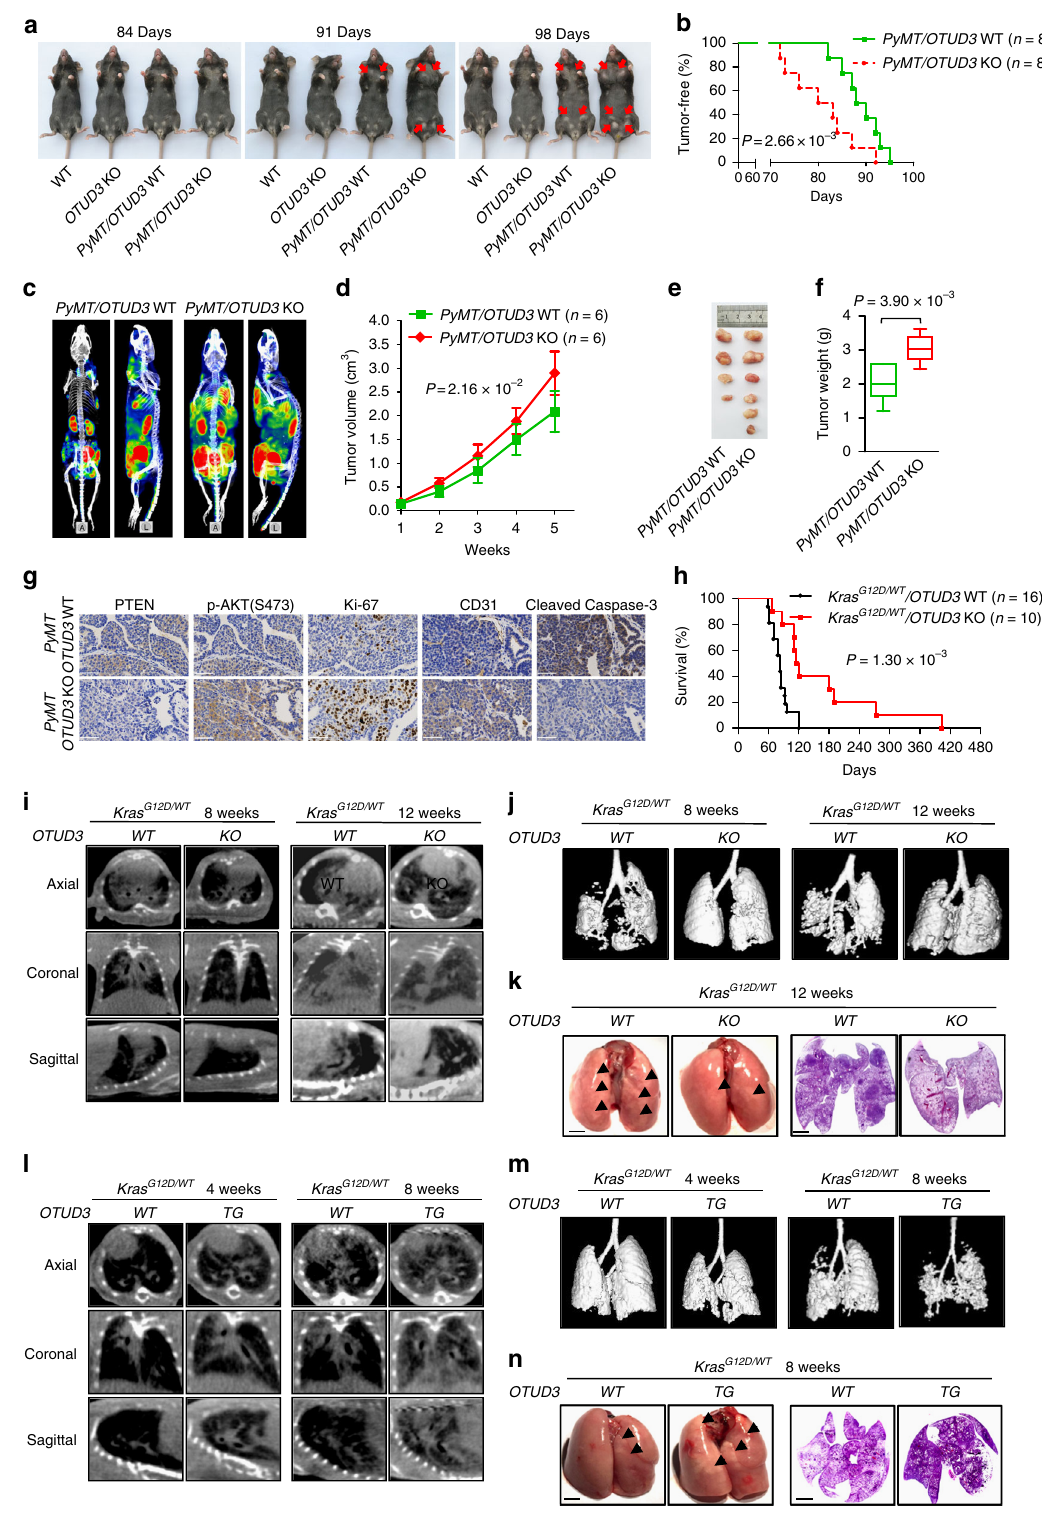
Fig. 1j – l). Importantly, tumor sections from Kras G12D/WT /OTUD3 KO mice exhibited decreased cell proliferation, shrinked angio- genesis, and accumulated cell apoptosis signals than that of tumor tissues from Kras G12D/WT /OTUD3 WT mice, as indicated with the Ki67, CD31, and cleaved Caspase-3 staining (Supplementary Fig.